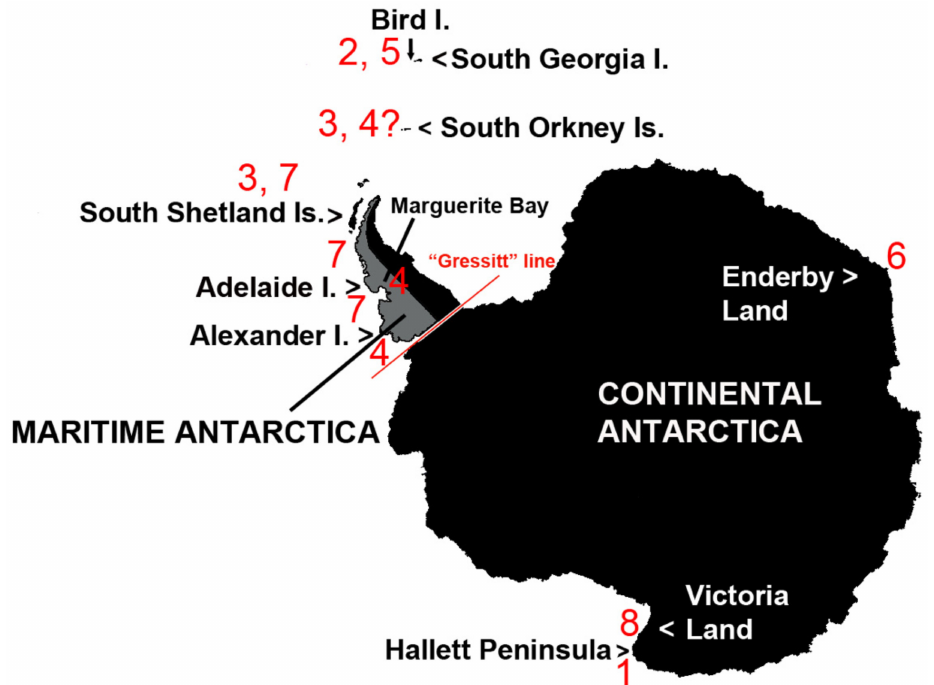
Figure 1. Map of the distribution of Antarctic Friesea species along major biogeographic regions of the continent. Species, with relative dates of identification, are listed according to their mention along the text as follows: (1) Friesea gretae (Greenslade and Fanciulli, 2020); (2) Friesea grisea (Schä ff er, 1891); (3) Friesea woyciechowskii (Weiner, 1890); (4) Friesea topo (Greenslade, 1995); (5) Friesea fantaba (Greenslade, 2018); (6) Friesea eureka (Greenslade, 2018); (7) Friesea antarctica (Willem, 1902); (8) Friesea propria (Greenslade and Fanciulli, 2020). The “Gressitt” line demarks the discontinuity between the biota of Antarctic Peninsula and that of Continental Antarctica. Data adapted from Greenslade [2] and Carapelli et al.